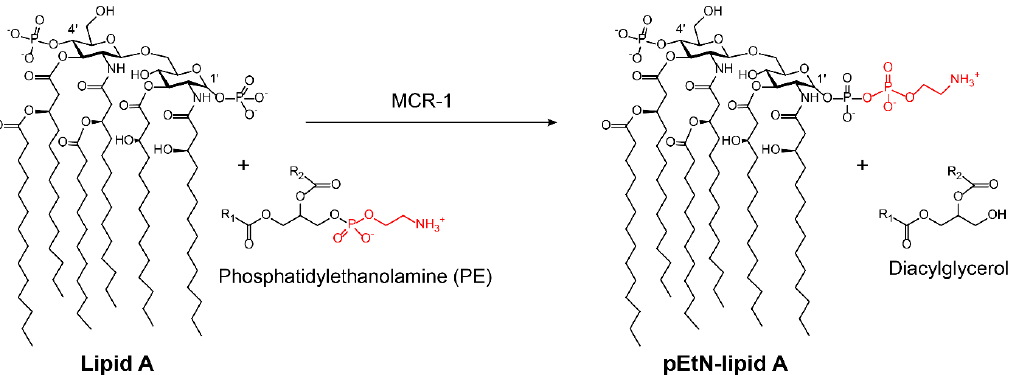
Figure 8. Scheme of bacterial lipid A modified by phosphatidylethanolamine (PE) through MCR-1 [121]. The modified groups on the antibiotic are in red; pEtN: phosphoethanolamine.